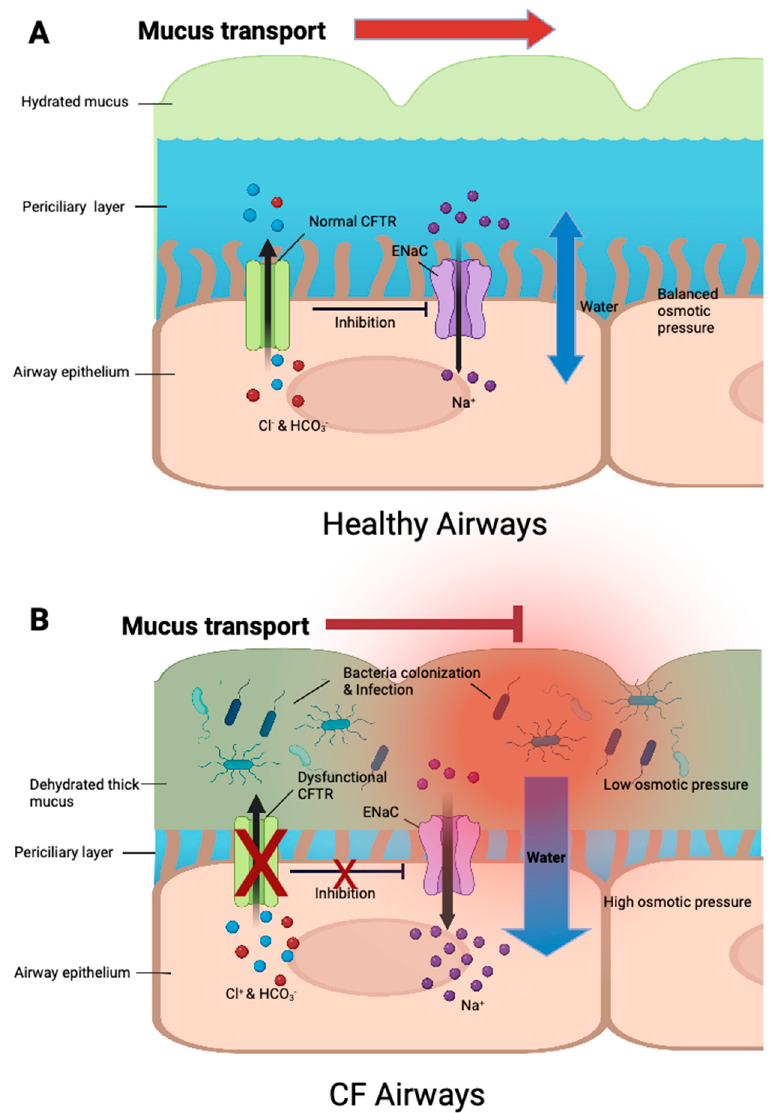
Figure 1. The regulation of ion transport and mucus hydration in healthy and CF airway surface. ( A ) In healthy airways, functional CFTR regulate Cl − and HCO 3 − secretions, and inhibits epithelial Na + channels (ENaC), contributing to the balance of intracellular and extracellular ion concentrations as well as osmotic pressure. Water movement is balanced, and mucus is well-hydrated, allowing the removal of pathogens. ( B ) In CF airways, dysfunctional or absent CFTR prevents Cl − and HCO 3